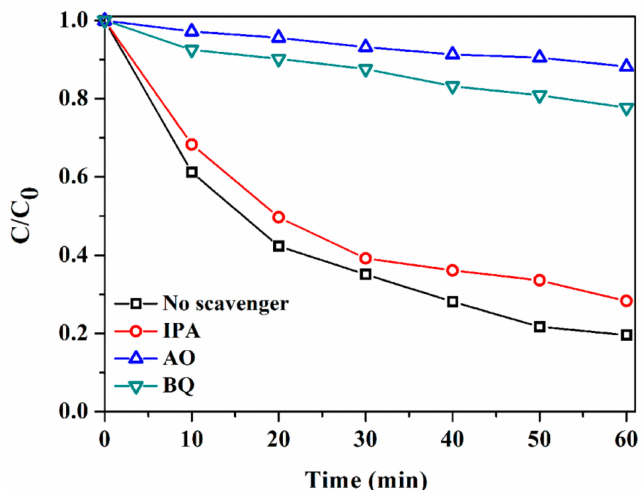
Figure 7. Photo-degradation of LEV (20 mg L − 1 , 100 mL) by1.0CdS/Bi 2 MoO 6 (35 mg) under